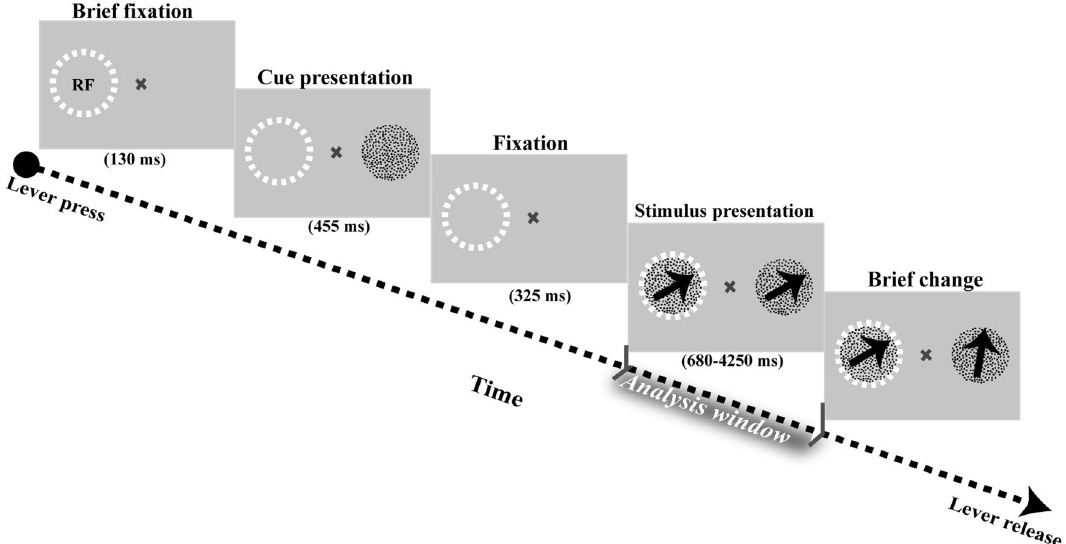
Figure 1. Experimental procedures. The monkey began each trial of the task by pressing a lever bar and maintaining its gaze on a fixation point (multiplication sign) for 130 ms. Then a static RDP appeared for 455 ms to show the position of the target stimulus on the screen to the animal. After the cue presentation, the screen became blank for 325 ms, and the monkey was required to preserve its gaze on the fixation point then. Next, two moving RDPs with the same direction of motion emerged on screen for a random period of 680–4250 ms. Immediately after, a direction change occurred in one of the two RDPs and the monkey was instructed to release the lever if the change happened in the cued position. The dashed circle indicates the classical RF of the neuron on the screen. The circle was not depicted to the monkey in the actual task experiments. All analyses were carried out on the analysis window during the stimulus presentation period, delineated by a grey shadow in the